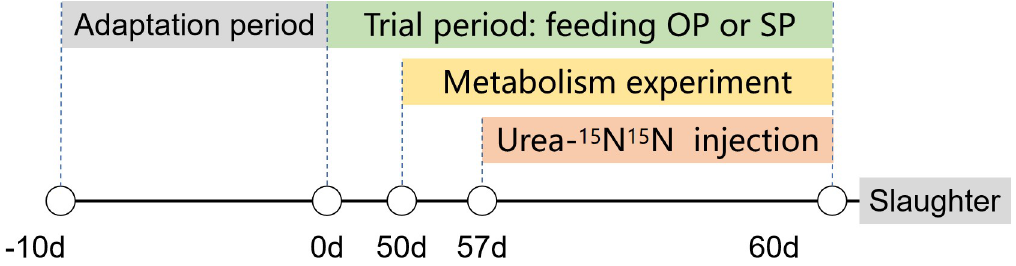
Fig 1. Diagram of experimental design. OP, oscillating crude protein concentrations diet; SP, static protein